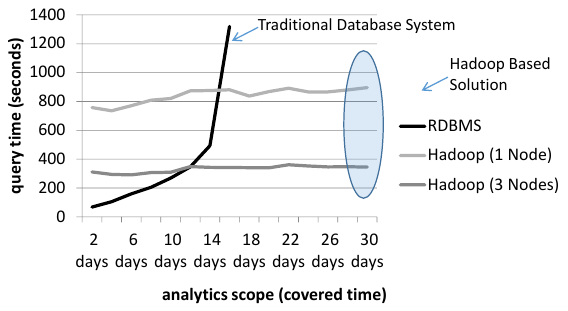
Figure 4: Comparison of query execution times with increas- ing database